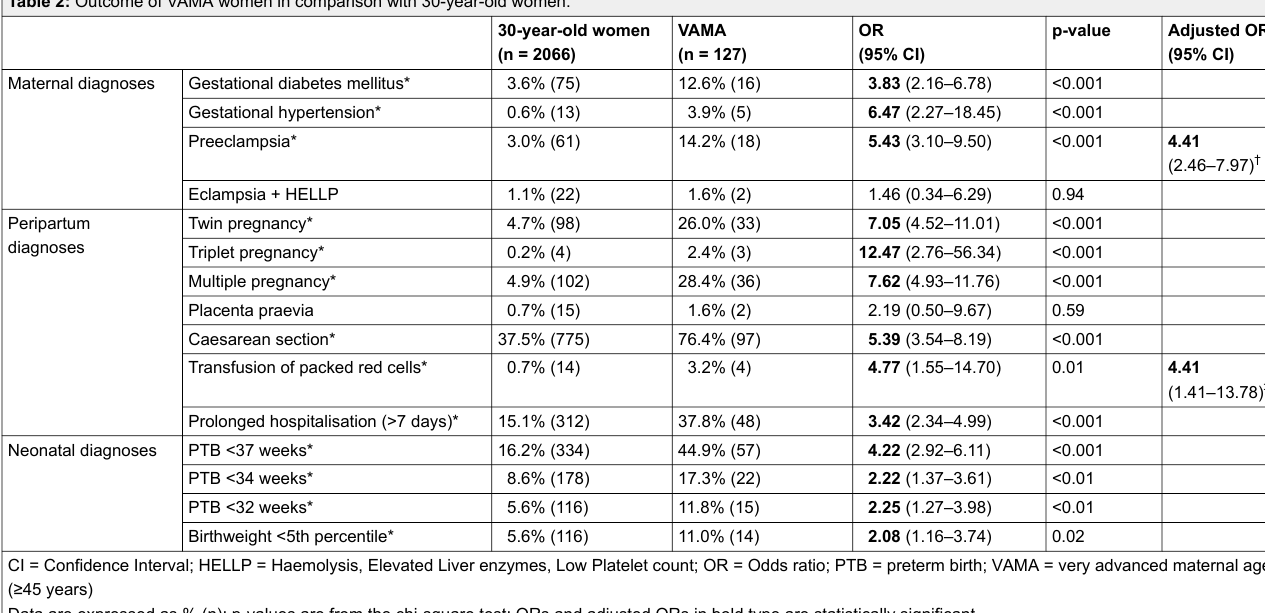
Table 2: Outcome of VAMA women in comparison with 30-year-old